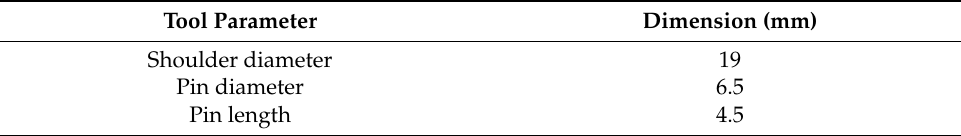
Table 4. Proposed dimensions for a tool using the suggested